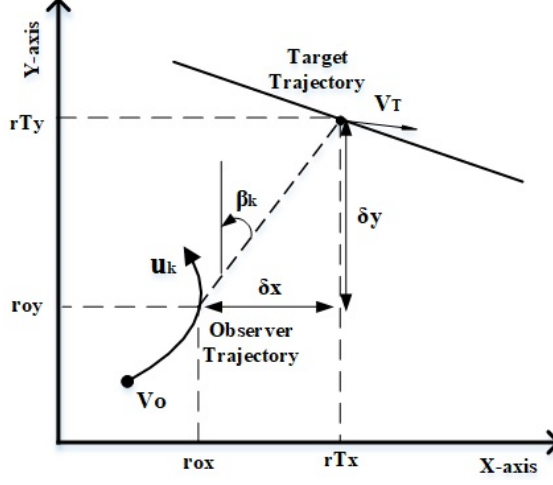
Figure 1. Target—Observer Geometry for BOT.